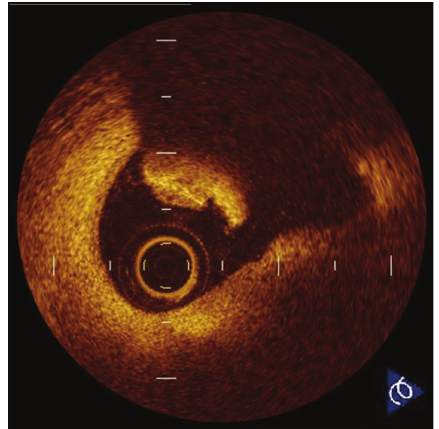
Figure 1: Plaque rupture. Plaque rupture is defined as a presence of fibrous-cap discontinuity (arrows) and a cavity formation ( ∗ ) in the plaque. Ruptured plaques usually have an extensive lipid core and a thin fibrous cap. The fibrous cap is the thinnest at the site of rupture, and the plaque cavity indicates loss of lipid core due to rupture.